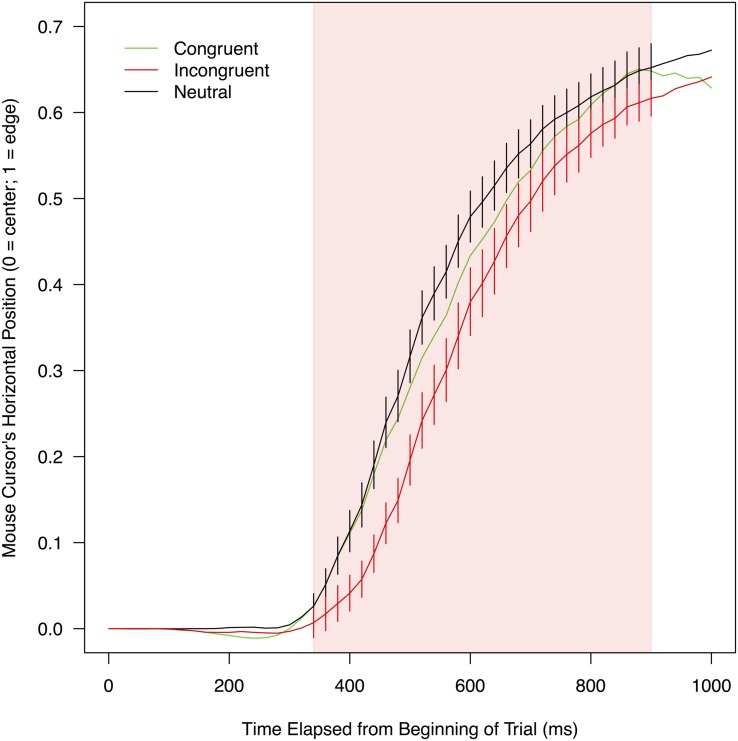
Mean horizontal positions of a mouse cursor on a screen as a function of experimental conditions and the time elapsed from the beginning of a trial. To compute these means, leftward trajectories were bilaterally flipped and pooled with rightward trajectories (for details, see section “Mouse Trajectory” under “RESULTS” of the text). The red shade indicates the time range (320–900 ms) in which mouse movements toward correct responses were significantly delayed when stimulus color words were written in incongruent colors (compared to when the stimulus words were neutrally colored in white). Error bars shown in this range represent 95% confidence intervals.